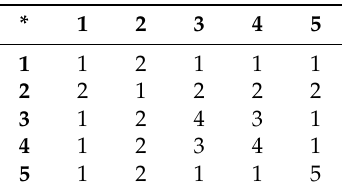
Table 5. The operation * on N